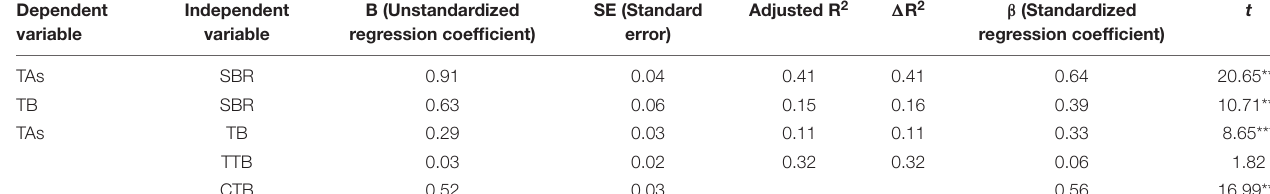
TABLE 3 | Regression analysis results of SBR level, teaching ability and teaching beliefs ( N = 625).